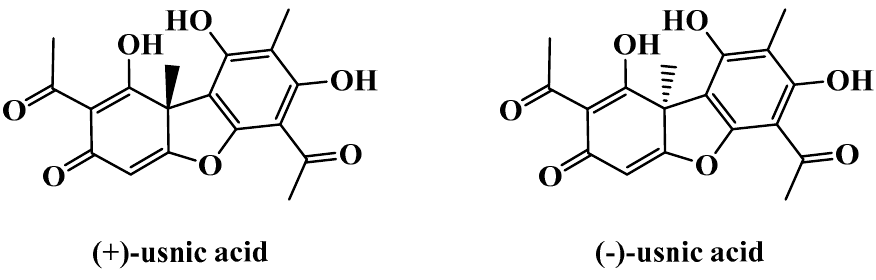
Figure 2. Chemical structures of (+/ − )-usnic acid.